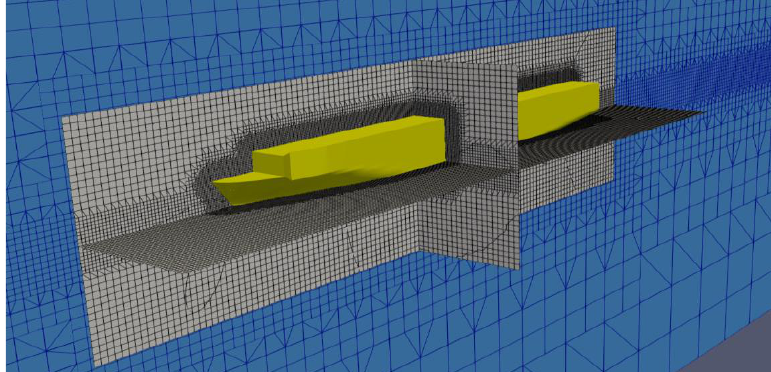
Figure 12. CFD mesh in the vicinity of the 6750 TEU containership.